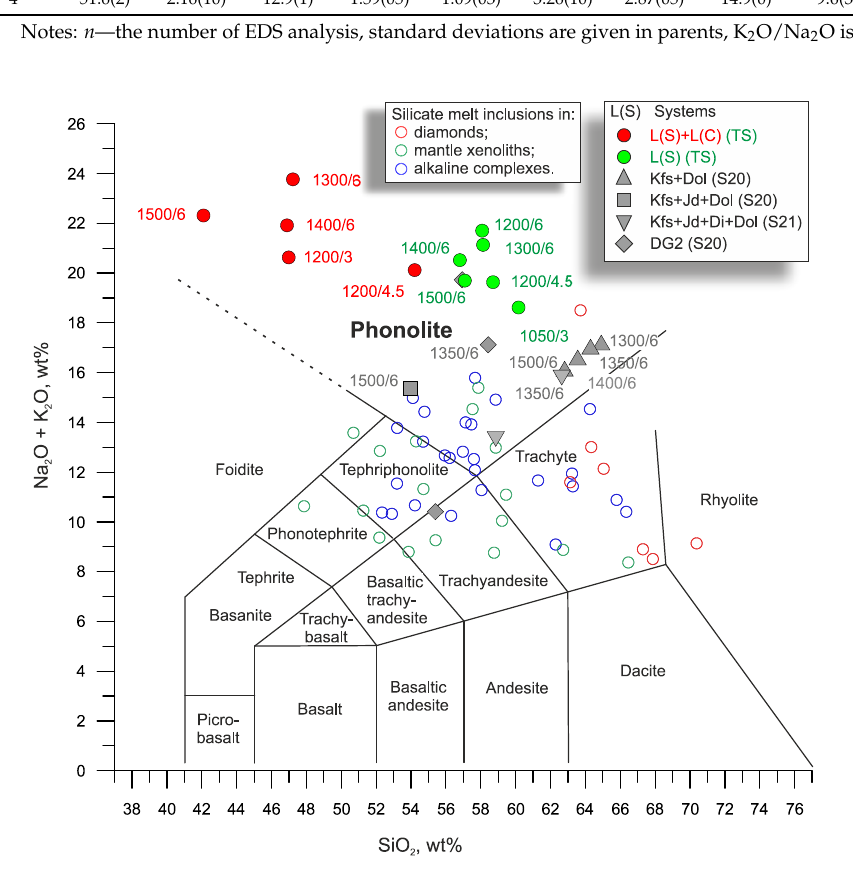
Figure 14. Silicate-melt compositions are plotted on the total alkali versus SiO 2 diagram (TAS). Fields for volatile-poor rocks are taken from [51]. The concentrations are from the volatile-free compositions normalized to 100 wt%. Silicate melts from experiments [16,18], diamond inclusions [52–56], mantle xenoliths [57,58] and alkaline complexes [59–61] are shown for comparison. TS—this study, S20—[18], S21—[17]. Kfs + Dol, and Kfs + Jd + Dol, and Kfs + Jd + Di + Dol are the system compositions expressed in mineral mole ratios.